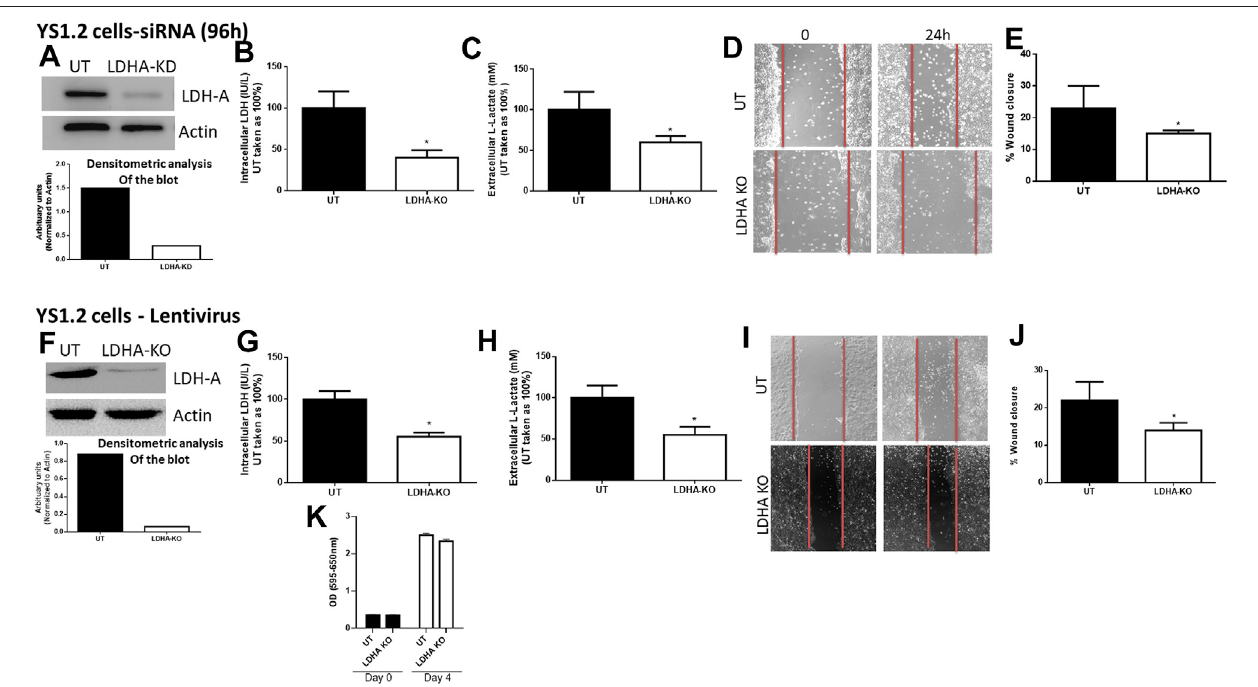
FIGURE2| EffectofLDH-AknockdownintheER+vebreastcancercellYS1.2. (A) showwesternblottinganalysisofLDH-Aandactin(loadingcontrol)inuntreated (UT), or cells treated with LDH-A siRNA for 96 h. Densitometric analysis ofthe blot is also included. The blot represents one out of three similar experiments. (B,C) show LDH activity and lactate level respectively. * p < 0.05 Vs. UT cells ( n (cid:2) 3 per group). (D,E) show the percentage of wound closure (using scratch assay). * p < 0.05 Vs. UT cells ( n (cid:2) 6 per group). (F) show western blotting analysis of LDH-A and actin (loading control) in untreated (UT), or cells treated with LDH-A lentivirus. Densitometric analysis of the blot is also included. The blot represents one out of three similar experiments. (G,H) show LDH activity and lactate level respectively. * p < 0.05 Vs. UT cells ( n (cid:2) 3 per group). (I,J) show the percentage of wound closure (using scratch assay). * p < 0.05 Vs. UT cells ( n (cid:2) 6 per group). (K) show cell proliferation (using MTT assay) at day 0 (seeding day) and day 4 ( n (cid:2) 3 per